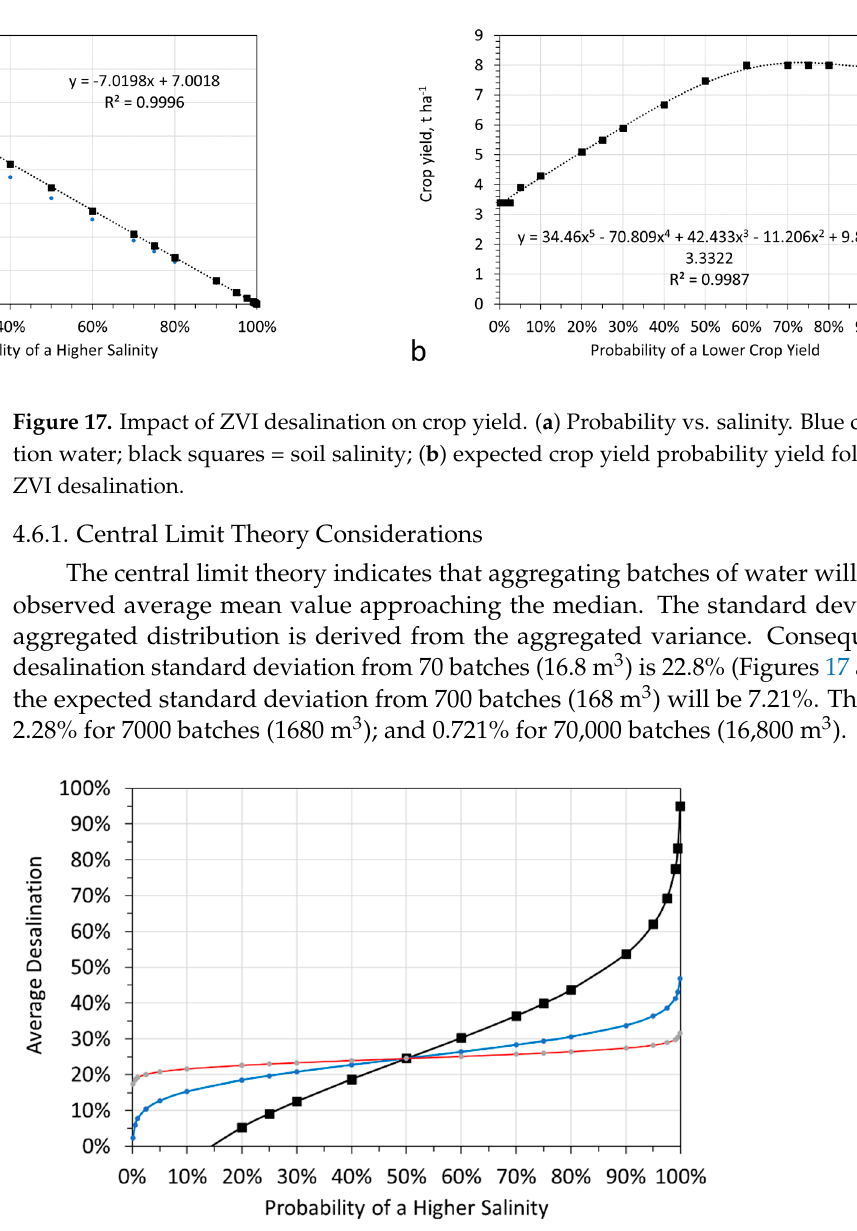
Figure 18. Expected average desalination distribution as a function of the number of batches aggre ‐ gated. Black = 70 batches (16.8 m 3 ); blue = 700 batches (168 m 3 ); red = 7000 batches (1680 m 3 ). As ‐ sumption from central limit theorem (sd 7000 batches = (((sd 70 batches) 2 (7000/70)) 0.5 )/(7000/70). sd = standard deviation. The distribution is defined by the expected normal order statistic, u